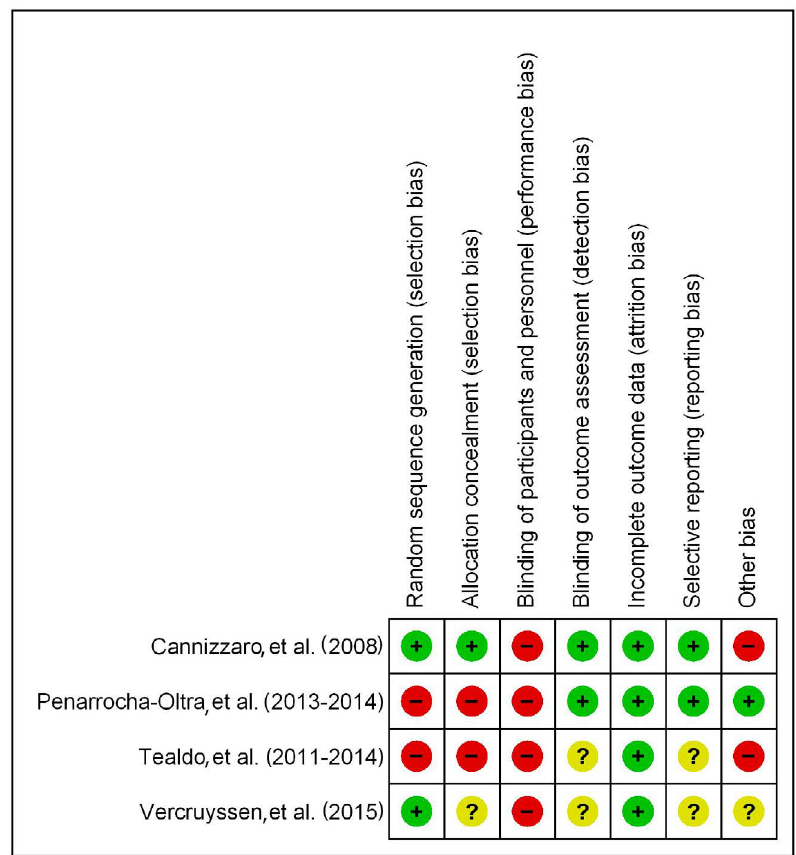
Figure 2- Risk of bias summary for included studies: evaluations on risk of bias concerning each potential source and type of bias. A + signifies that the corresponding approach to minimize bias was probably done (adequately described) for a given study, whereas a - discloses an evident limitation in controlling bias. A question mark underscores that the study provides insufficient description for judging a given approach as adequate or